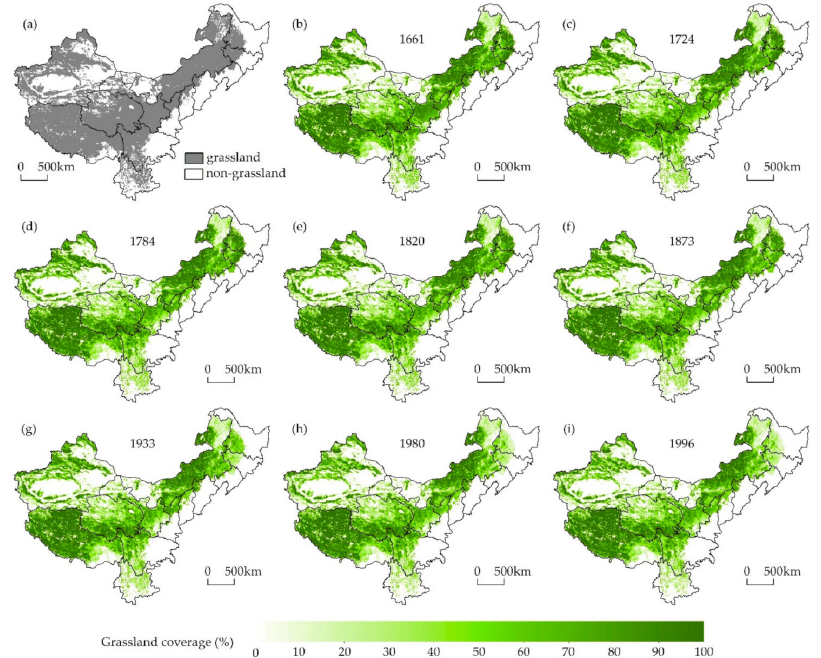
Figure 6. Maps showing grassland cover across western China for ( a ) the period without land reclamation; ( b ) 1661; ( c ) 1724; ( d ) 1784; ( e ) 1820; ( f ) 1873; ( g ) 1933; ( h ) 1980; and ( i ) 1996. No grasslands are present within white areas.